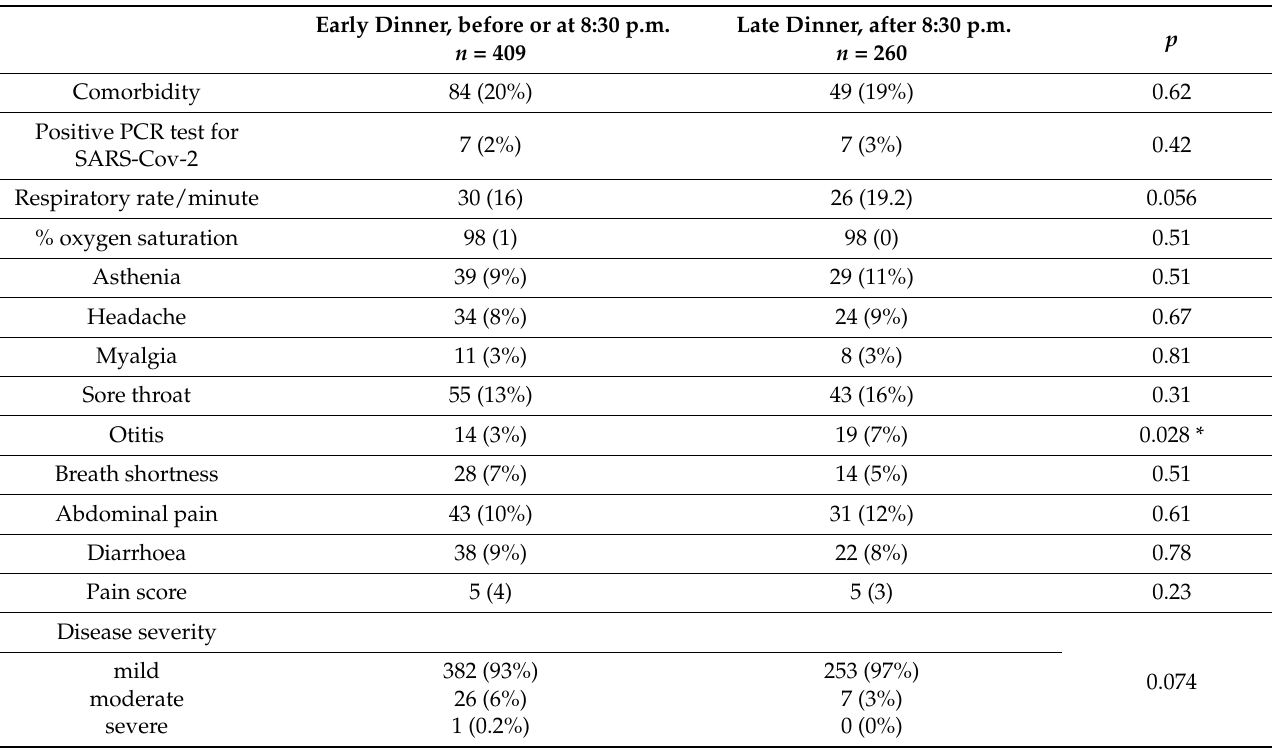
Table 3. Differences in clinical characteristics between early and late dinner